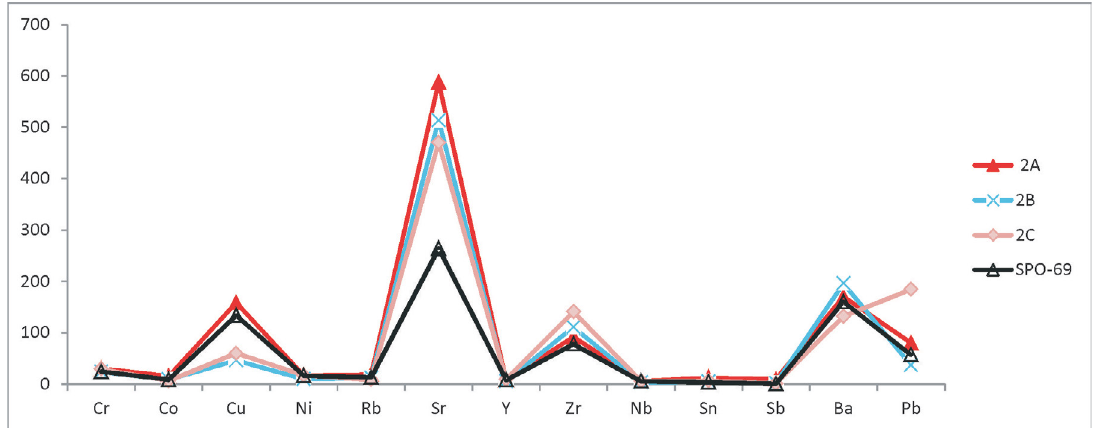
Figure 10: Spider diagram showing the average of trace element patterns of the second